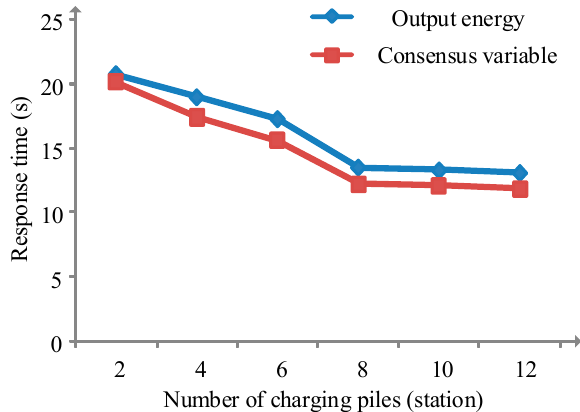
Figure 11. Response time under different communication capabilities.